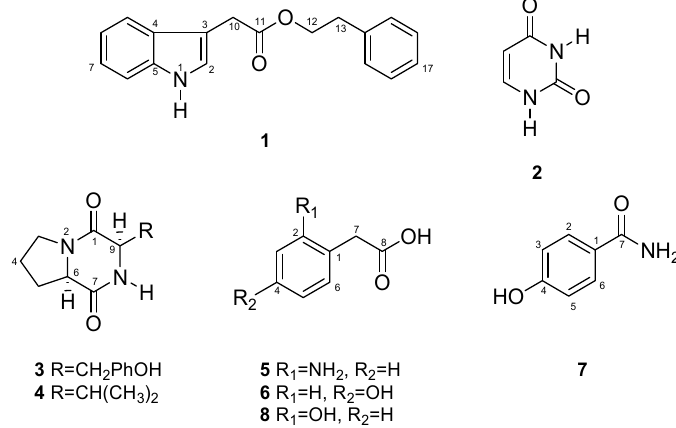
Figure 1. Metabolites produced by Colletotrichum gloeosporioides